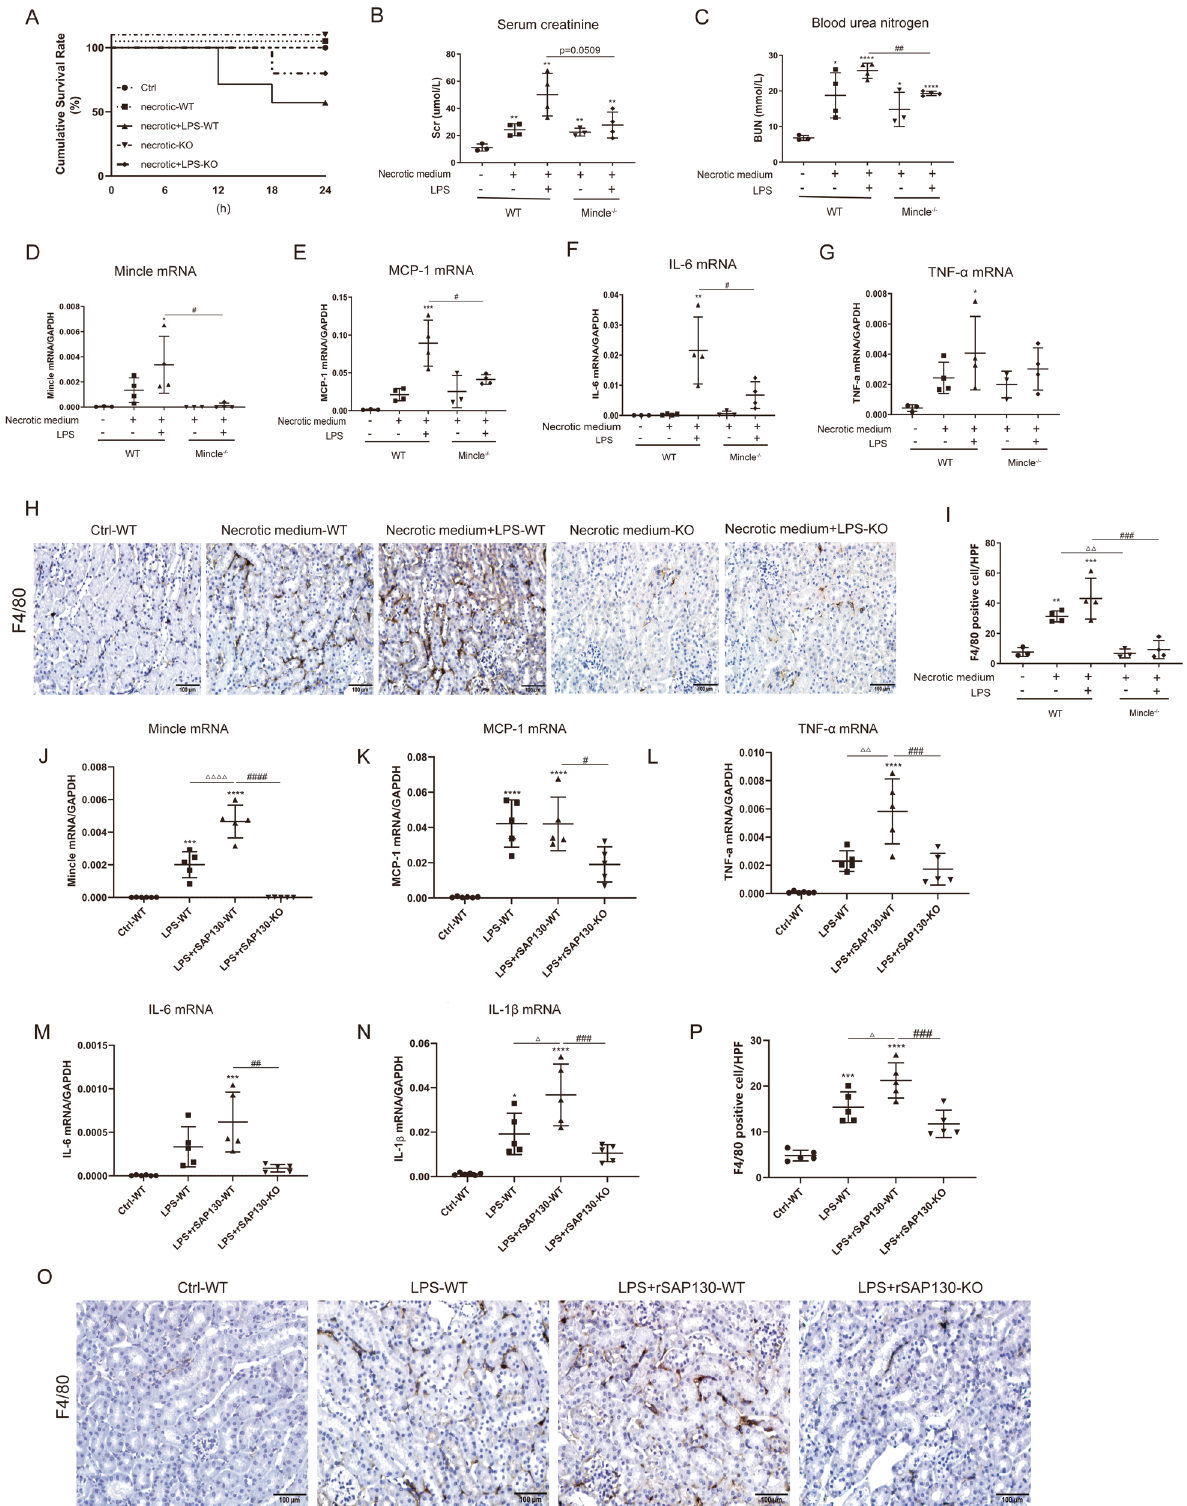
sections from mice and patients, respectively. For IHC, formalin- fi xed and paraf fi n-embedded kidney sections were incubated with primary anti- bodies against F4/80 (ab6640, Abcam, UK) and CD68 (ab201340, Abcam, UK), an ultrasensitive streptavidin peroxidase detection system was used for detection (MXB Biotechnologies, Foochow, China). Quantitative